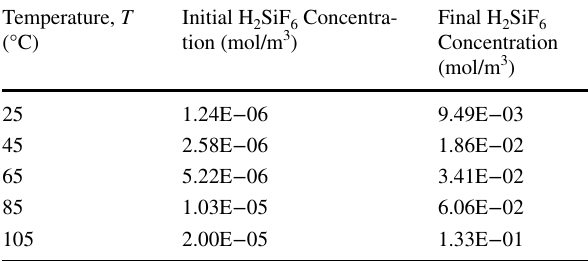
Table 7 Effect of temperature on H